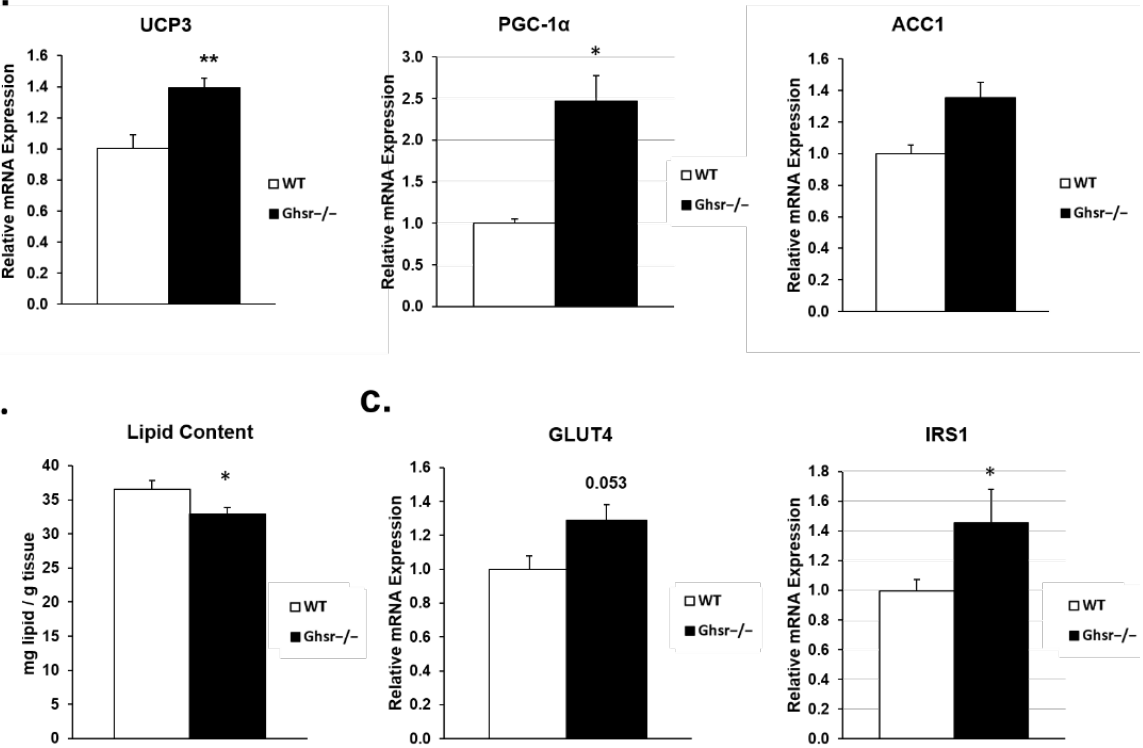
Figure 2. Effects of GHS-R ablation on metabolic dysfunction of aging muscle. Gastrocnemius mus- cle was from old (18‒2 6 m) WT (open bar) and Ghsr −/− (black bar) mice. ( a ) UCP3 , PGC-1 α and ACC1 mRNA expression. ( b ) Lipid content in gastrocnemius muscle. ( c ) Relative expression of IRS1 and GLUT4 in gastrocnemius muscle. 18s and β -actin house-keeping genes were used as internal con- trols in qPCR analysis. Two-tailed Student’s t -tests were completed, and data are presented as means ± standard error ( n = 9). * p < 0.05, ** p < 0.001, Ghsr −/− . vs. WT.